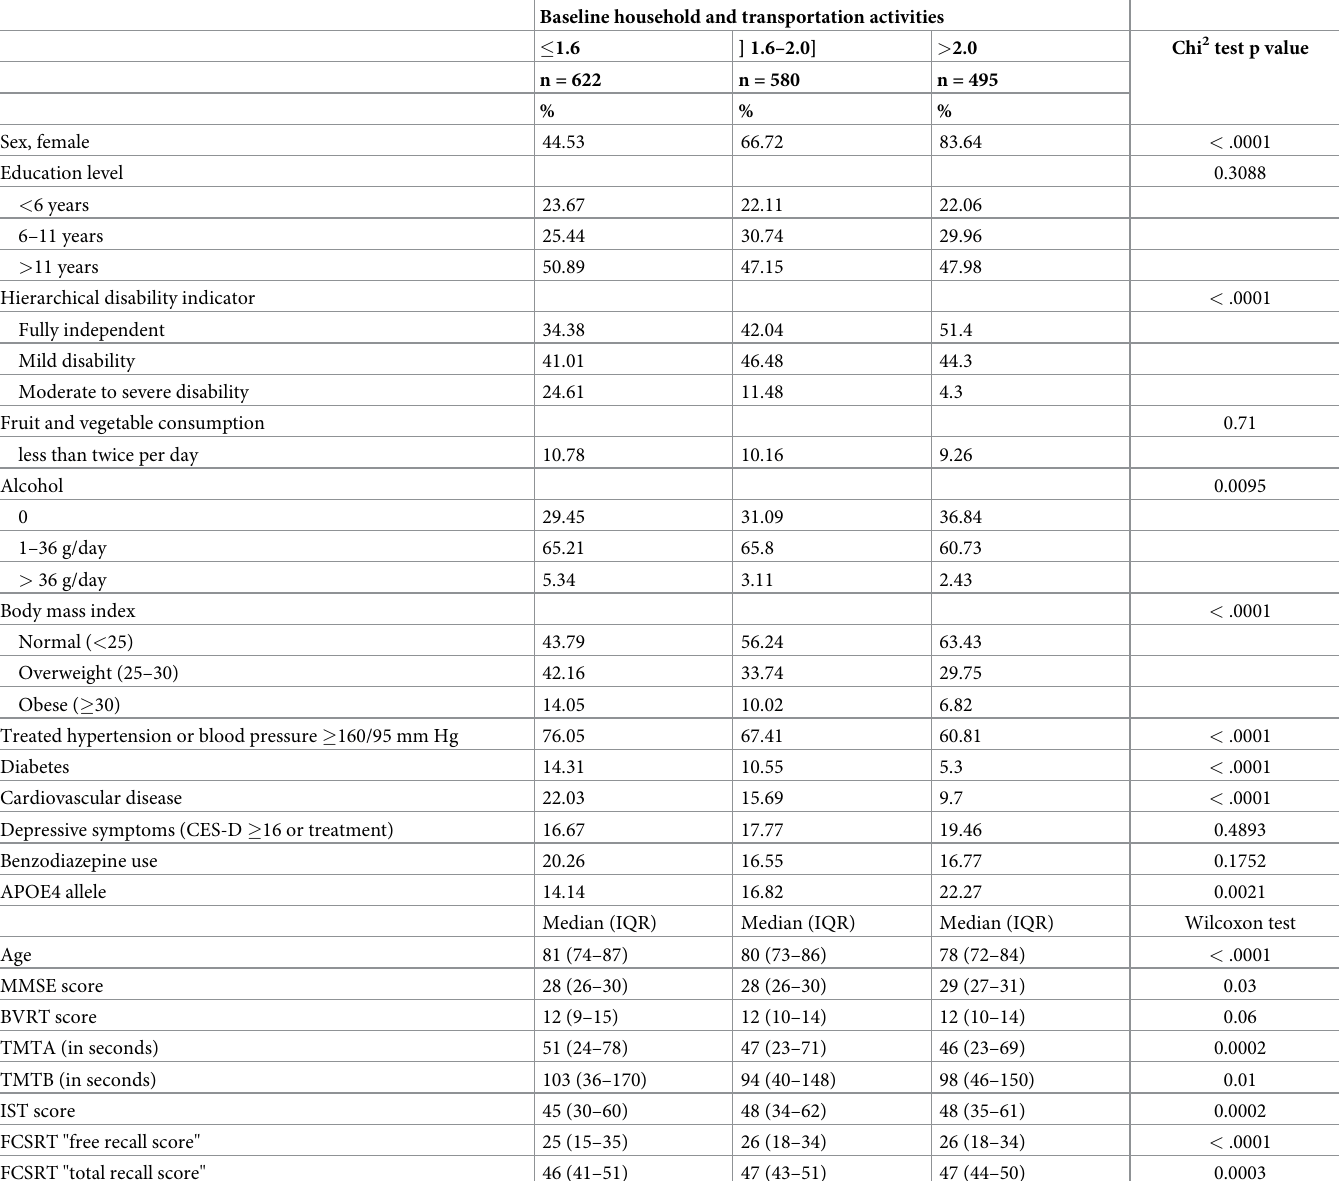
Table 1. Participants’ characteristics according to their level of household and transportation-related physical activities, n =